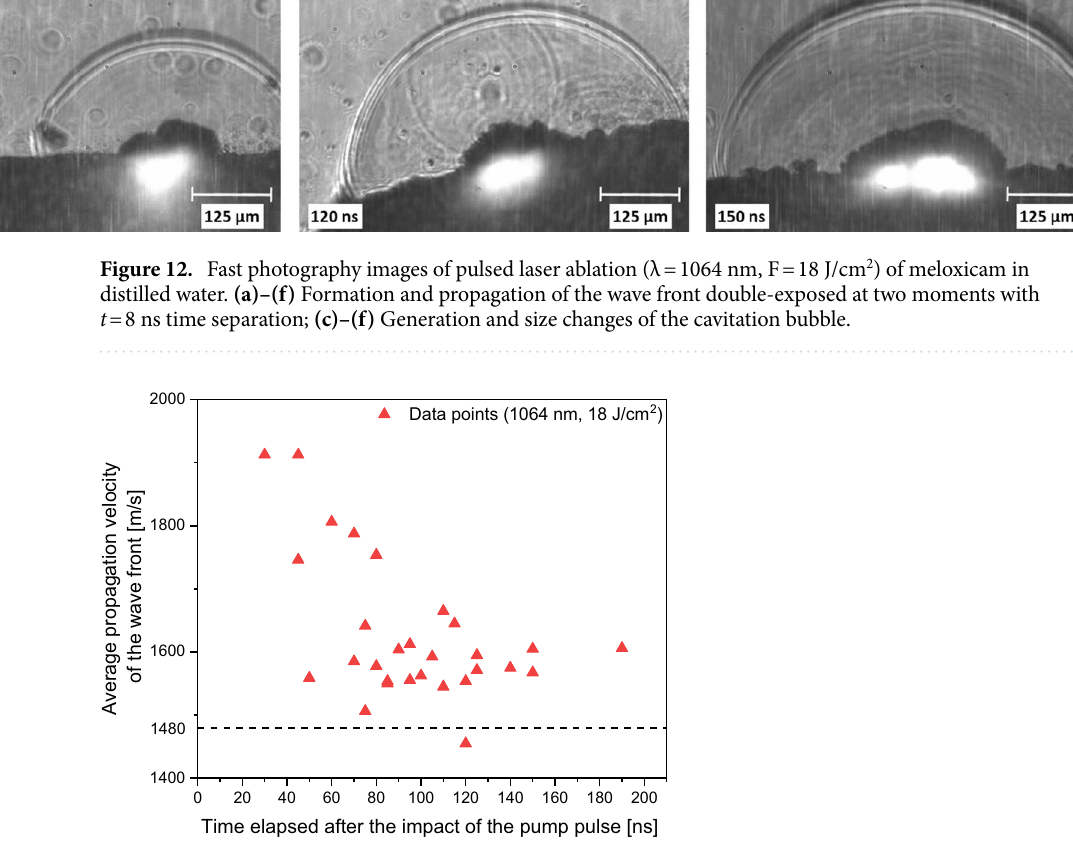
Figure 13. Time dependence of the propagation velocity of the wave front produced by PLAL (λ = 1064 nm, F = 18 J/cm 2 ) of meloxicam in distilled